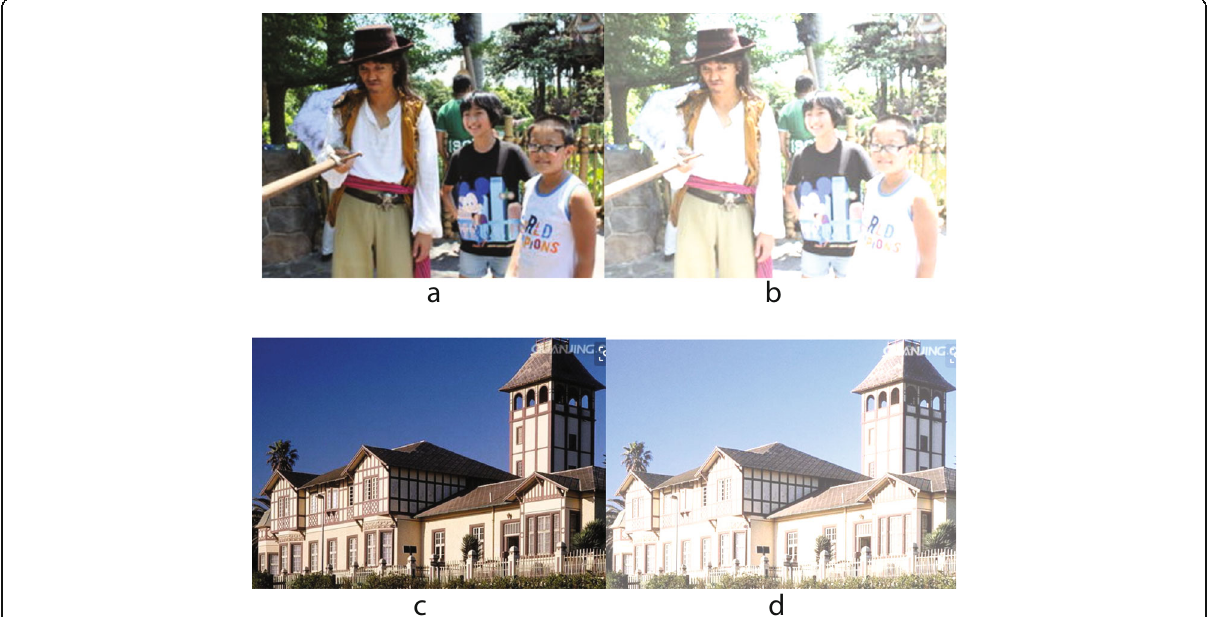
Fig. 5 Non-photorealistic art processing results applying the proposed algorithm. a Figure scene picture. b Non-photorealistic art processing result picture. c Architectural drawing. d Non-photorealistic art processing result